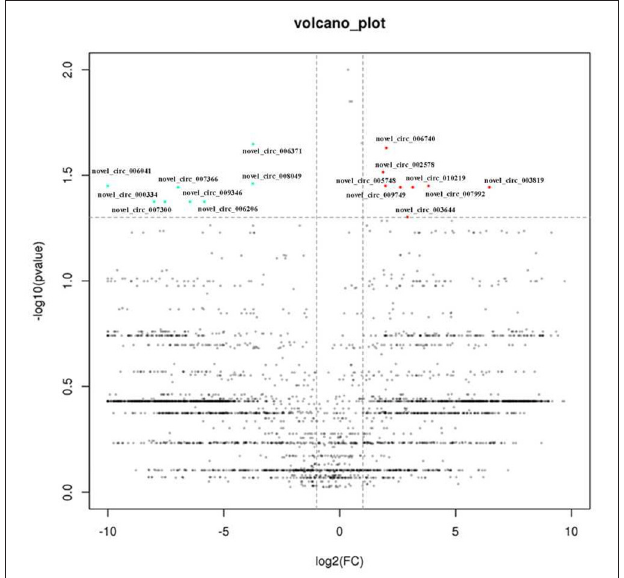
FIGURE 5 | Volcano plots of the differential expressed circRNAS. The vertical lines correspond to 2.0 fold (log2 scaled) up and down, respectively, and the horizontal line represents a P -value of 0.05 (–log10 scaled). The red and green spots in plot represent the differentially expressed circRNAs with statistical signifcance.